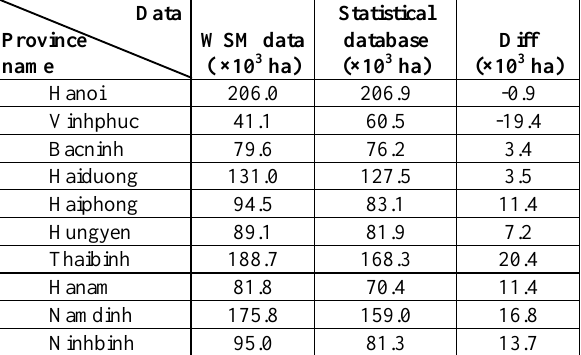
Table 2. Maximum planted area of rice by province (in ha) for all Season in period 5 year (2007-2011) from the statistical database and from the WSM data